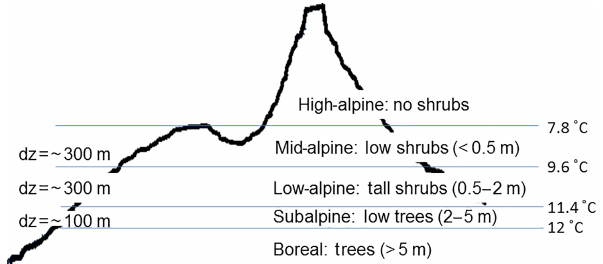
Figure 1. Illustration of alpine zones and corresponding dominating shrub vegetation. The altitudinal extent of each alpine zone is indi- cated by the values of elevation differences (d z ) and corresponding mean JJA temperatures dividing the zones based on mean summer lapse rates in the area.